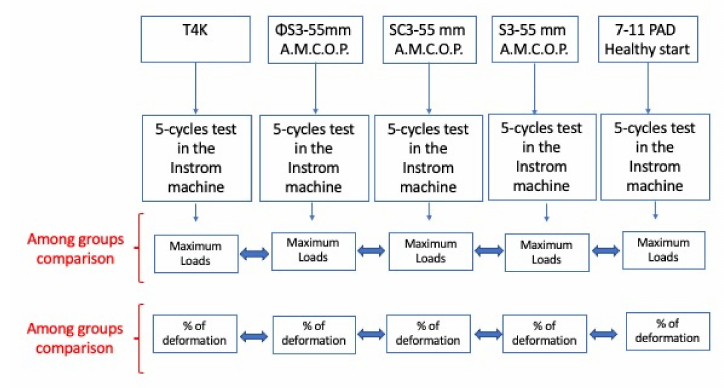
Figure 4. Research experimental